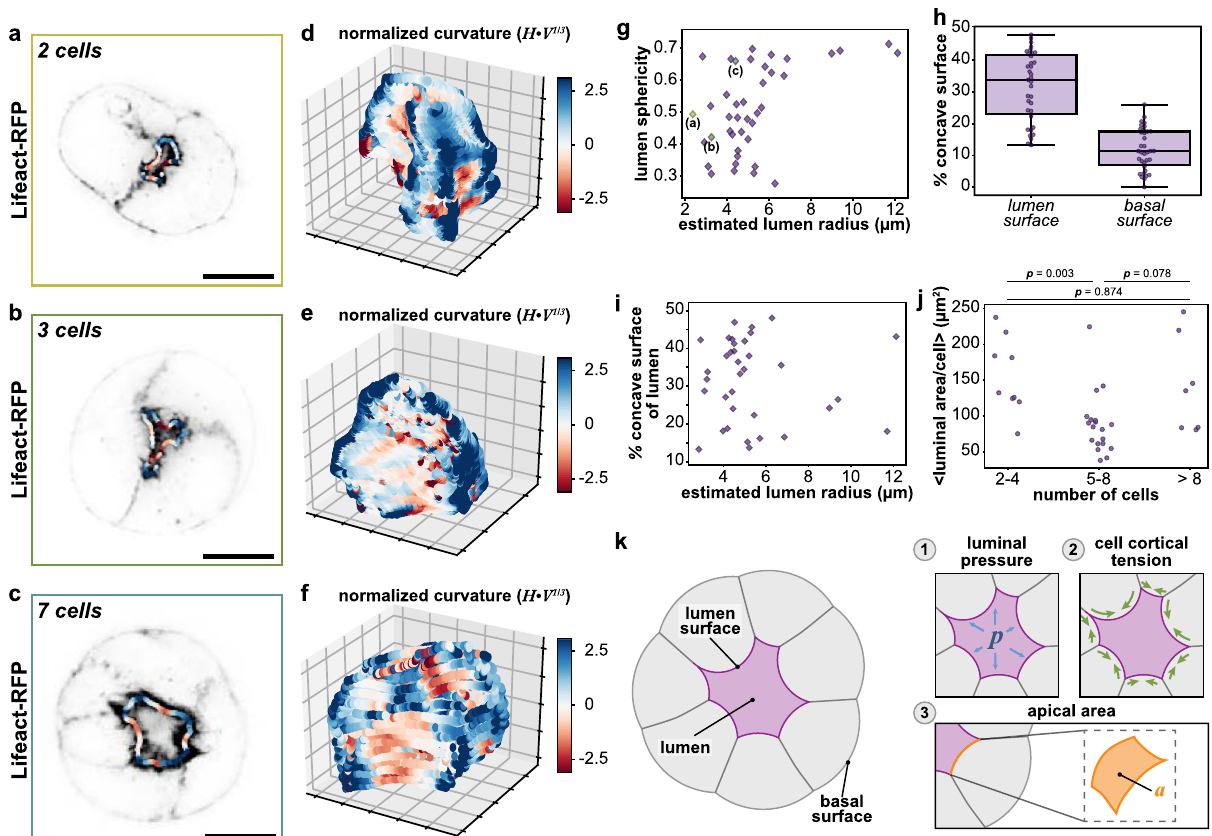
Fig. 1 Quanti fi cation of lumen morphology. a – c Representative single-plane images of MDCK spheroids expressing Lifeact-RFP (gray). The mean lumen curvature is superimposed as a red-blue outline, where red is concave (negative local curvature) and blue is convex (positive local curvature). d – f 3D contour plots of corresponding lumen surfaces showing volume normalized ( V ) local mean curvatures ( H ), where red is concave (negative local curvature) and blue is convex (positive local curvature). g Lumen sphericities plotted as a function of estimated lumen radius. Estimated lumen radius ( r ) was calculated using lumen volume ( V ): r = (3 V /4 π ) 1/3 . Values for representative spheroids from a – c as indicated. h Percent of lumen surface (left) and basal surface (right) that is concave (negative curvature). i Percent of lumen surface that is concave (negative curvature) as a function of estimated lumen radius, as determined by lumen volume. j Mean luminal surface area per cell plotted as a function of number of cells in the spheroid ( p -values from two- sided rank sum test). k Schematic depicting physical forces that could determine luminal shape. (1) luminal pressure ( p ) (2) cell cortical tension and (3) apical area ( a ). Scale bars are 10 μ m. Box plot in h shows median, quartiles of dataset, and whiskers extending to maximum and minimum of distributions. For plots g – j , n = 35 spheroids. Source data are provided in the Source Data fi